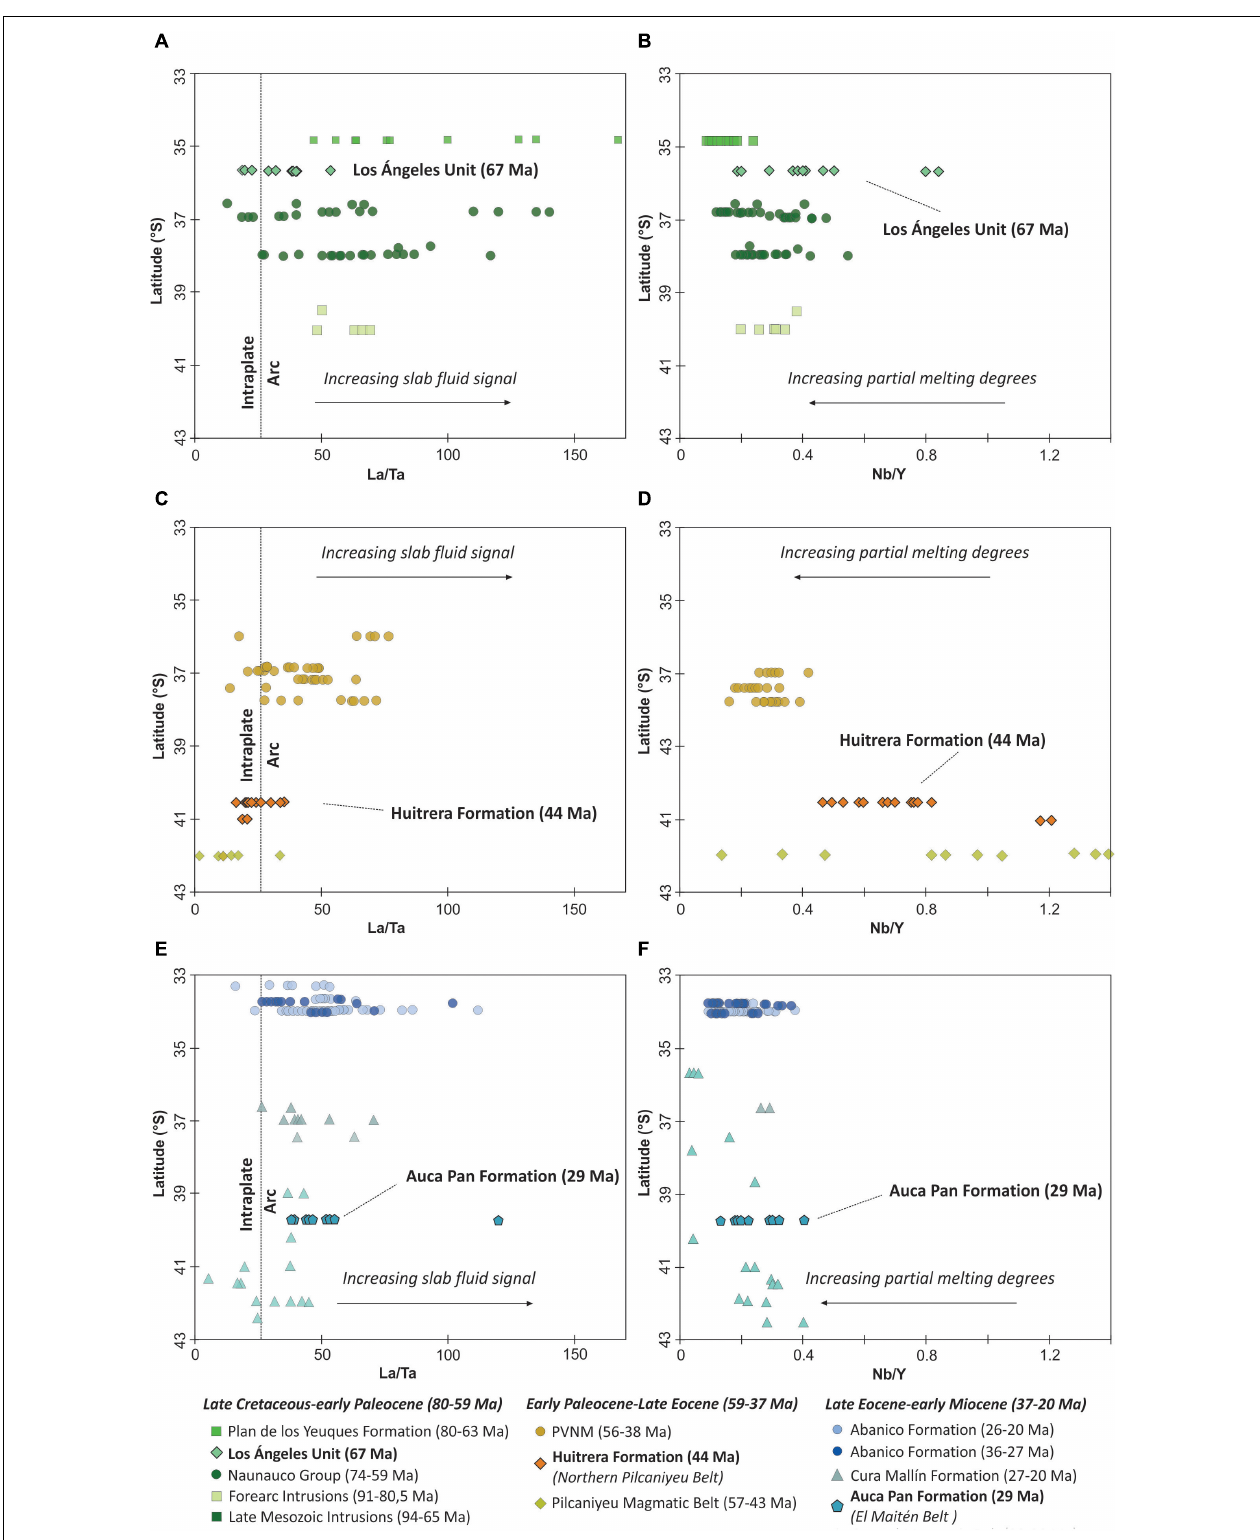
FIGURE 12 | (A,B) Latitude ◦ (S) vs. La/Ta and Latitude ( ◦ S) vs. Nb/Y for Late Cretaceous-early Paleocene magmatic units along the Southern Central Andes. (C,D) Latitud ( ◦ S) vs. La/Ta and Latitude ( ◦ S) vs. Nb/Y for early Paleoceno-late Eocene magmatic units along the Southern Central Andes. (E,F) Latitud ( ◦ S) vs. La/Ta and Latitude ( ◦ S) vs. Nb/Y for late Eocene-early Miocene magmatic units along the Southern Central Andes. These diagrams show the variations in slab-fluid influence and partial melting degrees regarding the time and location of emplacement for each magmatic sequence.